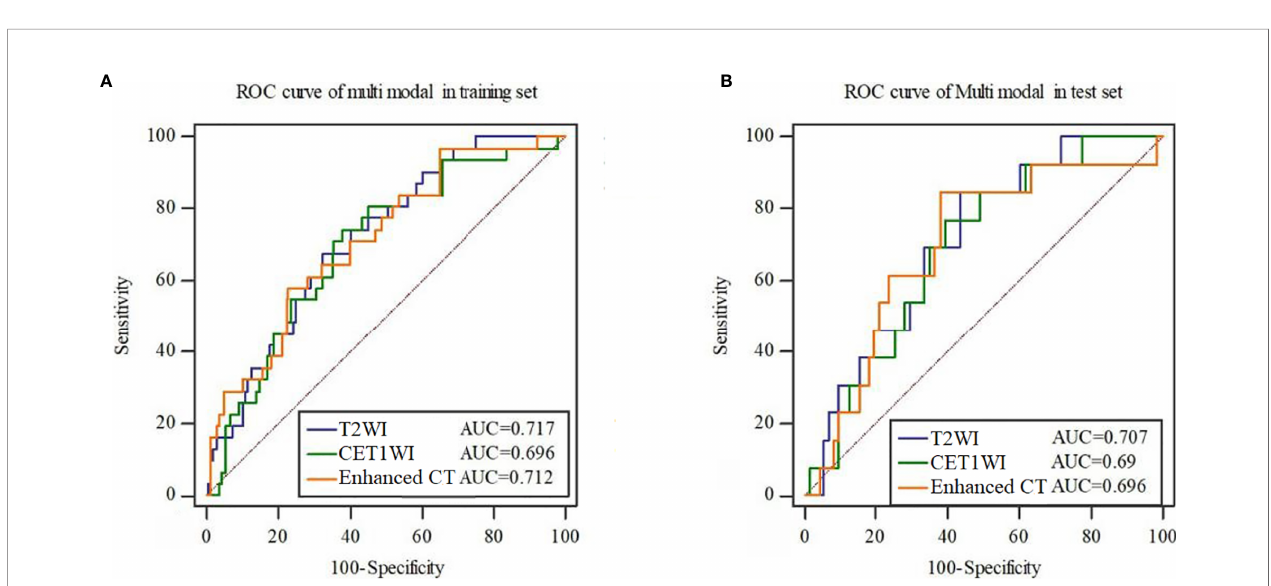
FIGURE 3 | ROC curves of the radiomics signature constructed by each mode in the training set (A) and test set (B) .